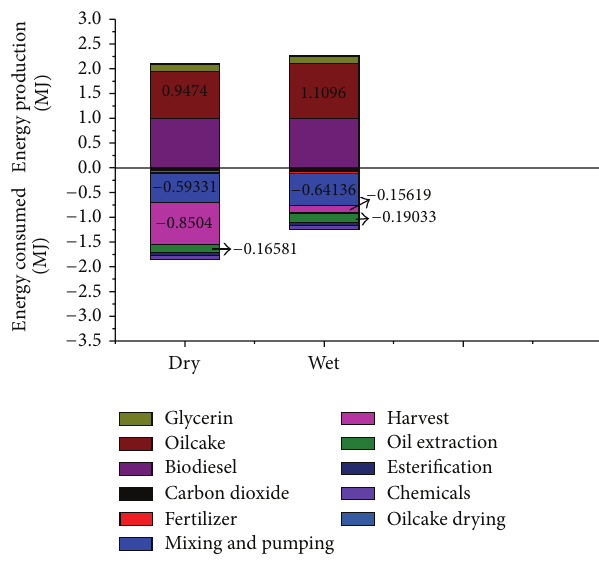
Figure 4: Chlorella vulgaris . Energy losses and gains for the produc- tion of biodiesel from Chlorella vulgaris grown in N-sufficient and N-limited mediums.